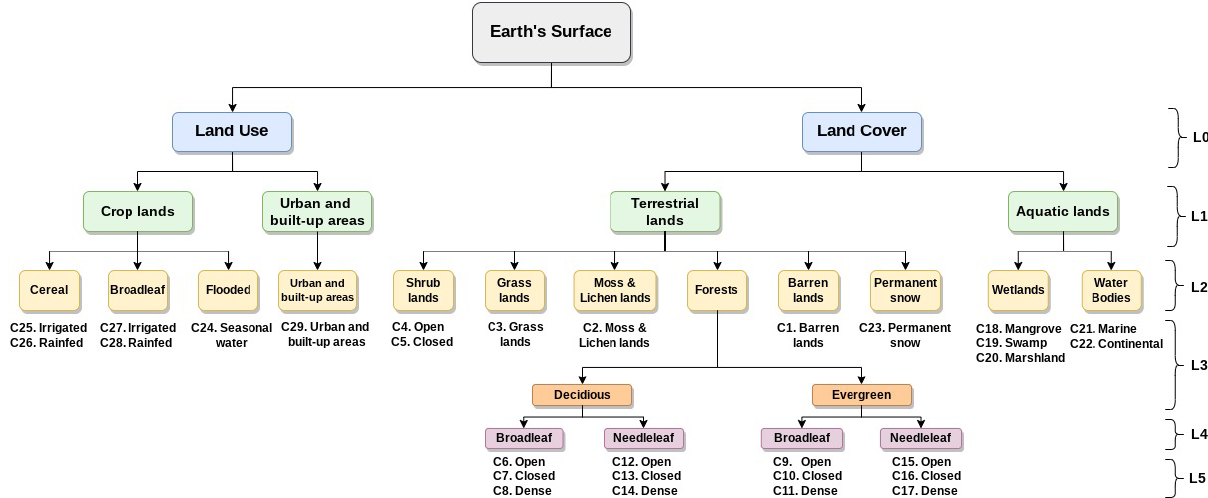
Figure 1. Hierarchical structure of the LULC classes contained in the TimeSpec4LULC dataset. C1 to C29: the 29 LULC classes. L0 to L5: the 5 LULC levels. L0 includes the 2 blue boxes. L1 includes the 4 green boxes. L2 includes the 12 yellow boxes. L3 includes all the classes of the 12 yellow boxes (from C1 to C5 and from C18 to C29) except the forests class where it includes only the 2 orange boxes (deciduous and evergreen). L4 includes the same classes but expands the forests class into the 4 purple boxes: deciduous (broadleaf and needleleaf) and evergreen (broadleaf and needleleaf). L5 includes all the 29 LULC classes (from C1 to C29).